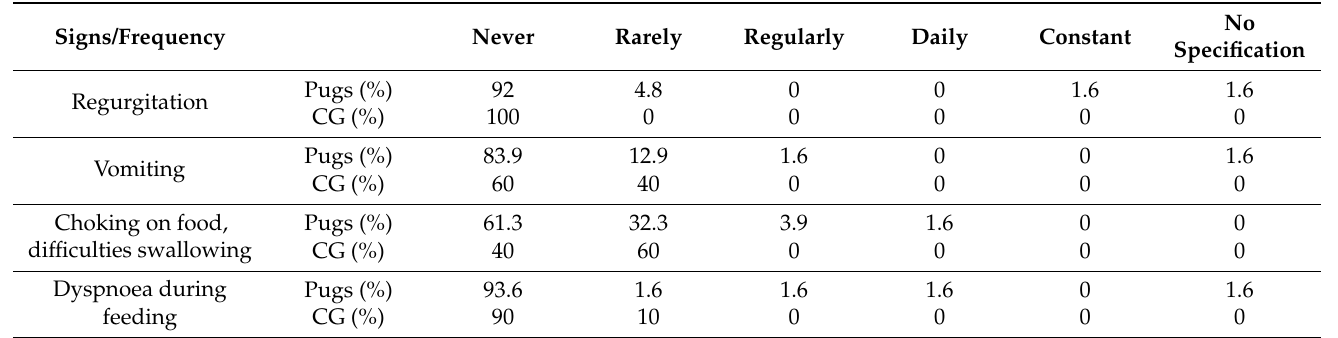
Table 9. Overview of problems with eating observed by the pug owners ( n = 62) and the control group (CG) dog owners ( n =